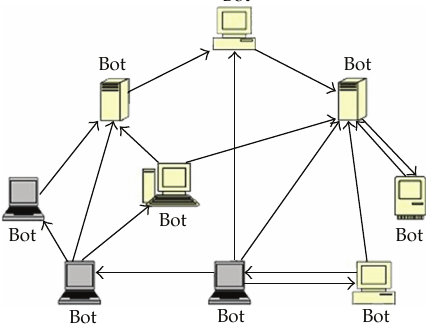
Figure 2: P2P botnet (cid:5) 18 (cid:6)